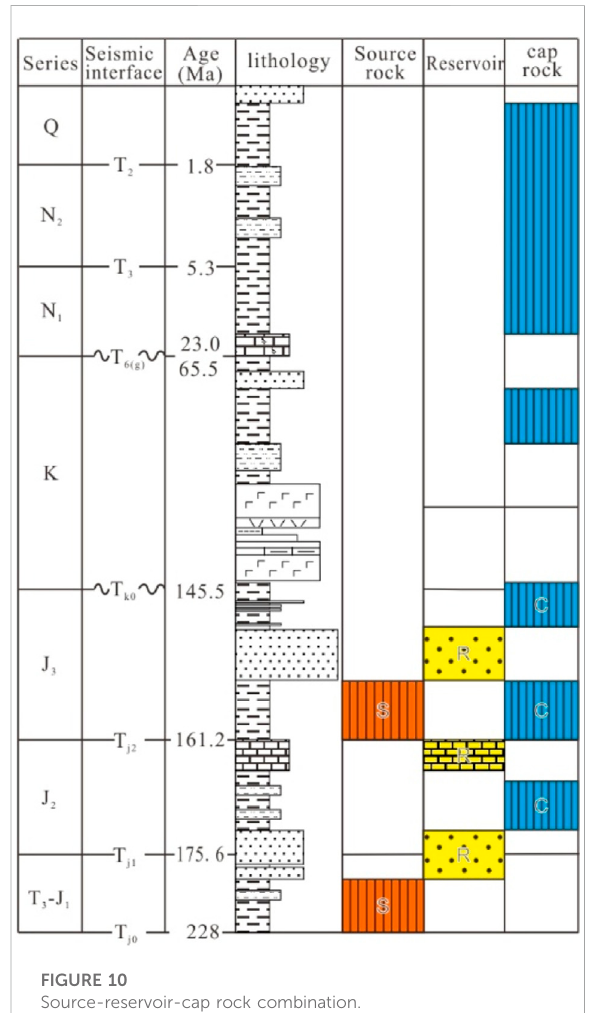
FIGURE 10 Source-reservoir-cap rock combination.